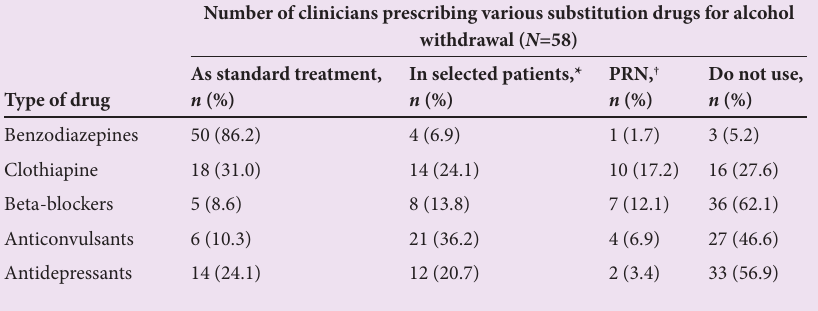
Table 1. Standard regimen of pharmacotherapy during alcohol withdrawal Number of clinicians prescribing various substitution drugs for alcohol